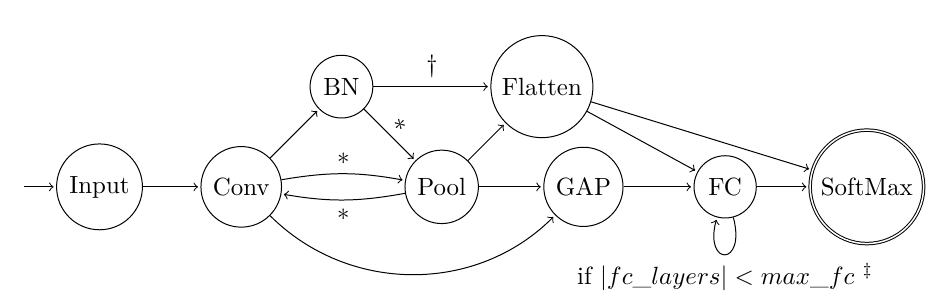
Figure 3: Our Markov Decision Process for generating a CNN architecture: The actions in the process are the addition of specific layers to the neural network being generated. ∗ Only allows transitions to layers with a smaller size than the current representation size. † Only available if the transition marked with ∗ is not available due to the current representation size. ‡ max_fc was set to three for all experiments, which is consistent with the state-of-the-art SCA results and helps keep the environment size down.